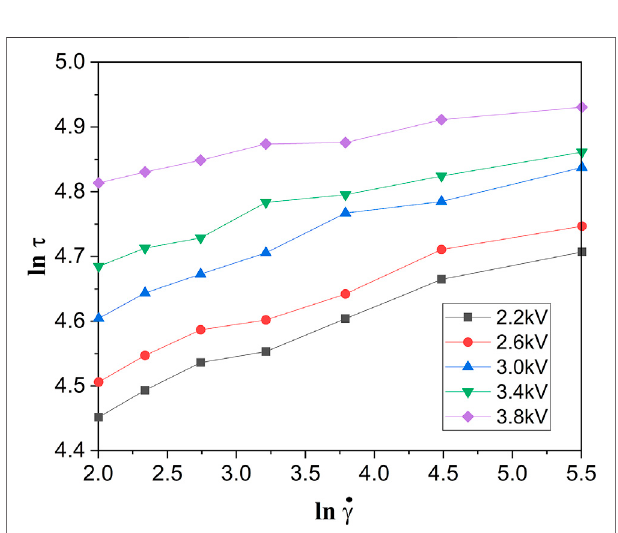
FIGURE 6 | Dynamic shear stress of